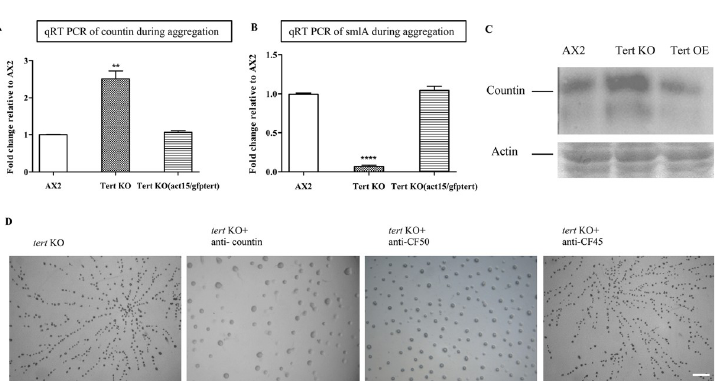
Fig 5. Tert regulates the levels of CF. qRT-PCR of (A) countin and (B) smlA during aggregation in AX2, tert KO and tert KO [act15/gfp-tert]. rnlA was used as mRNA amplification control. Level of significance is indicated as � p < 0.05, �� p < 0.01, ��� p < 0.001, and ���� p < 0.0001; (n = 3). (C) Western blots with anti-countin antibodies. The gels were stained with Coomassie to show equal loading; (n = 3). (D) Cells were starved and developed with anti-countin, CF50 and CF45 antibodies (1:300 dilution) on KK 2 agar plates. Addition of anti-countin and anti-CF50 antibodies rescued tert KO group size defect. Scale bar: 0.5 mm; (n = 3).